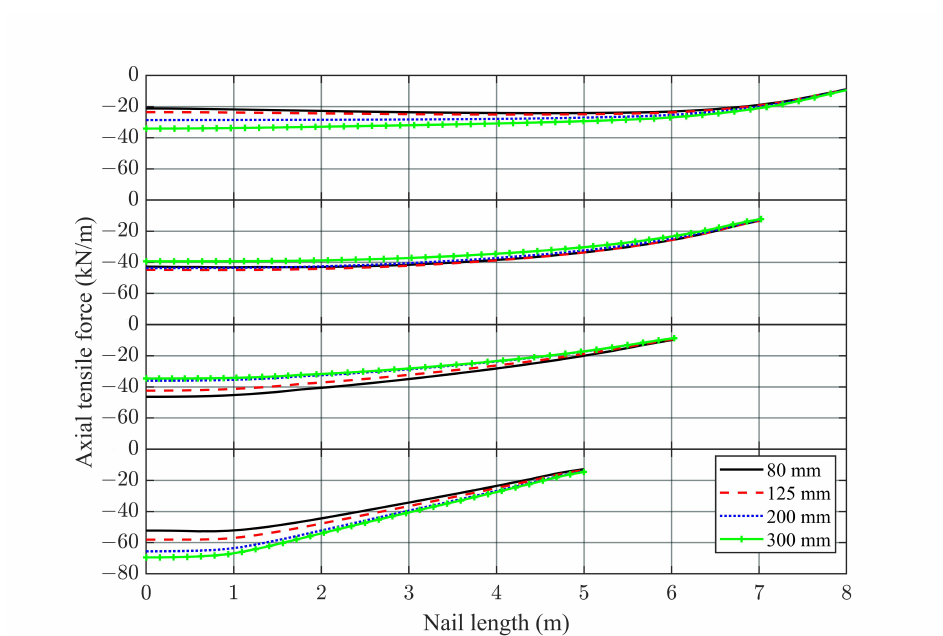
Figure 4. Distribution of nail axial force with various facing thicknesses.